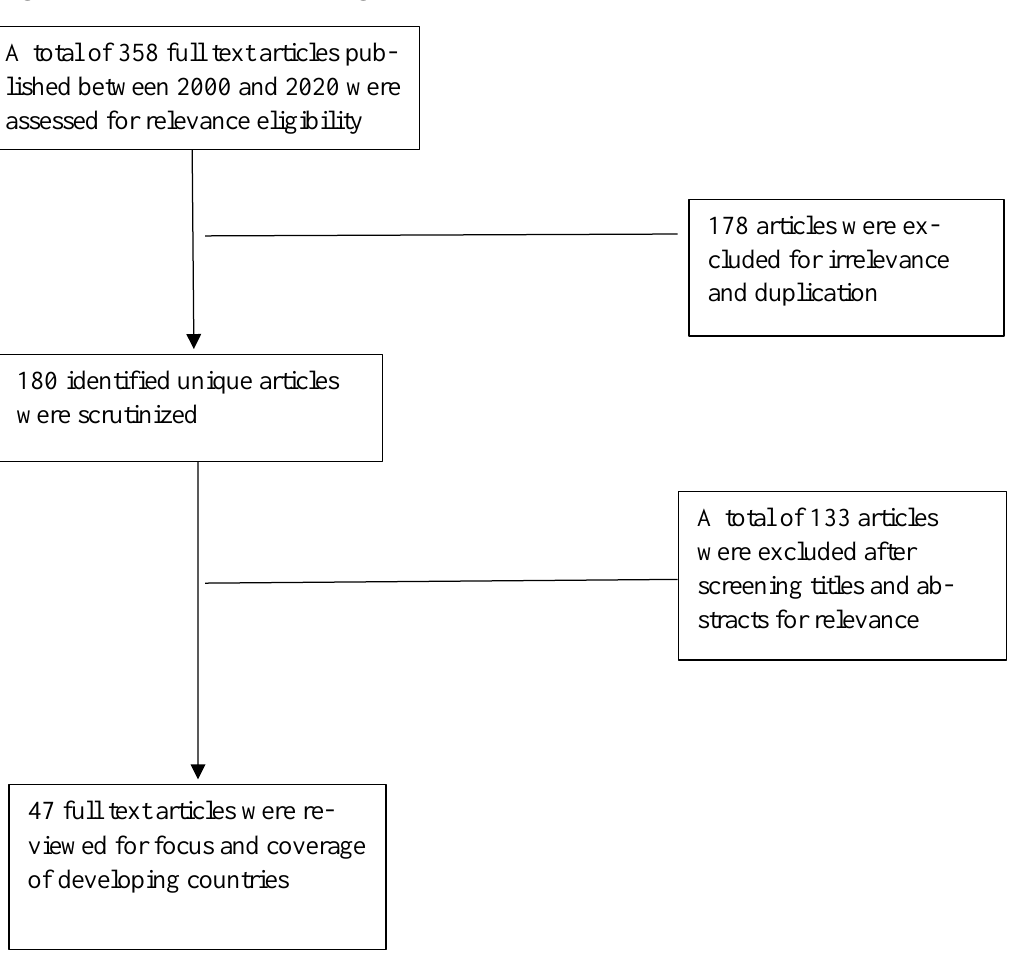
Figure 1: Flow chart showing detailed article extraction and evaluation